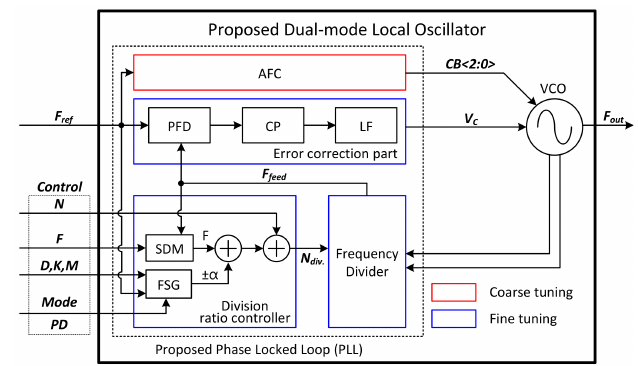
Figure 6. Block diagram of the proposed dual-mode LO.